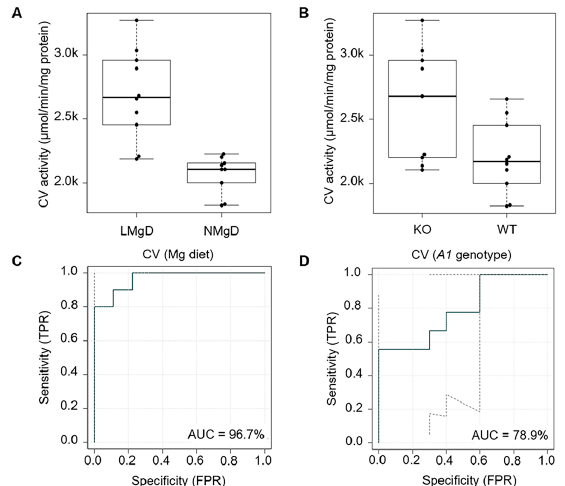
Figure 8. Impact of dietary Mg content and Slc41a1 genotype on the activity of complex V / F 1 F o -ATPase (CV) in murine cardiac mitochondria. ( A ) Box-and-whisker plot overlaid with dot plot showing the influence of dietary Mg content (LMgD vs. NMgD) and ( B ) Slc41a1 genotype ( Slc41a1 -/- vs. Slc41a1 +/+ ) on CV activity in murine mitochondria. For both, A and B, the original source data and corresponding medians are indicated for each group. The interaction of data is presented in Figure A2. ( C , D ) Empirical ROC (receiver operating characteristic) curves with the area under the ROC curve (AUC) for ( C ) the type of Mg diet as predictor of CV activity and ( D ) the Slc41a1 genotype as predictor of CV activity. Abbreviations: A1 , Slc41a1 ; FPR, false-positive rate; KO, knock-out; TPR, true-positive rate; WT, wild-type.